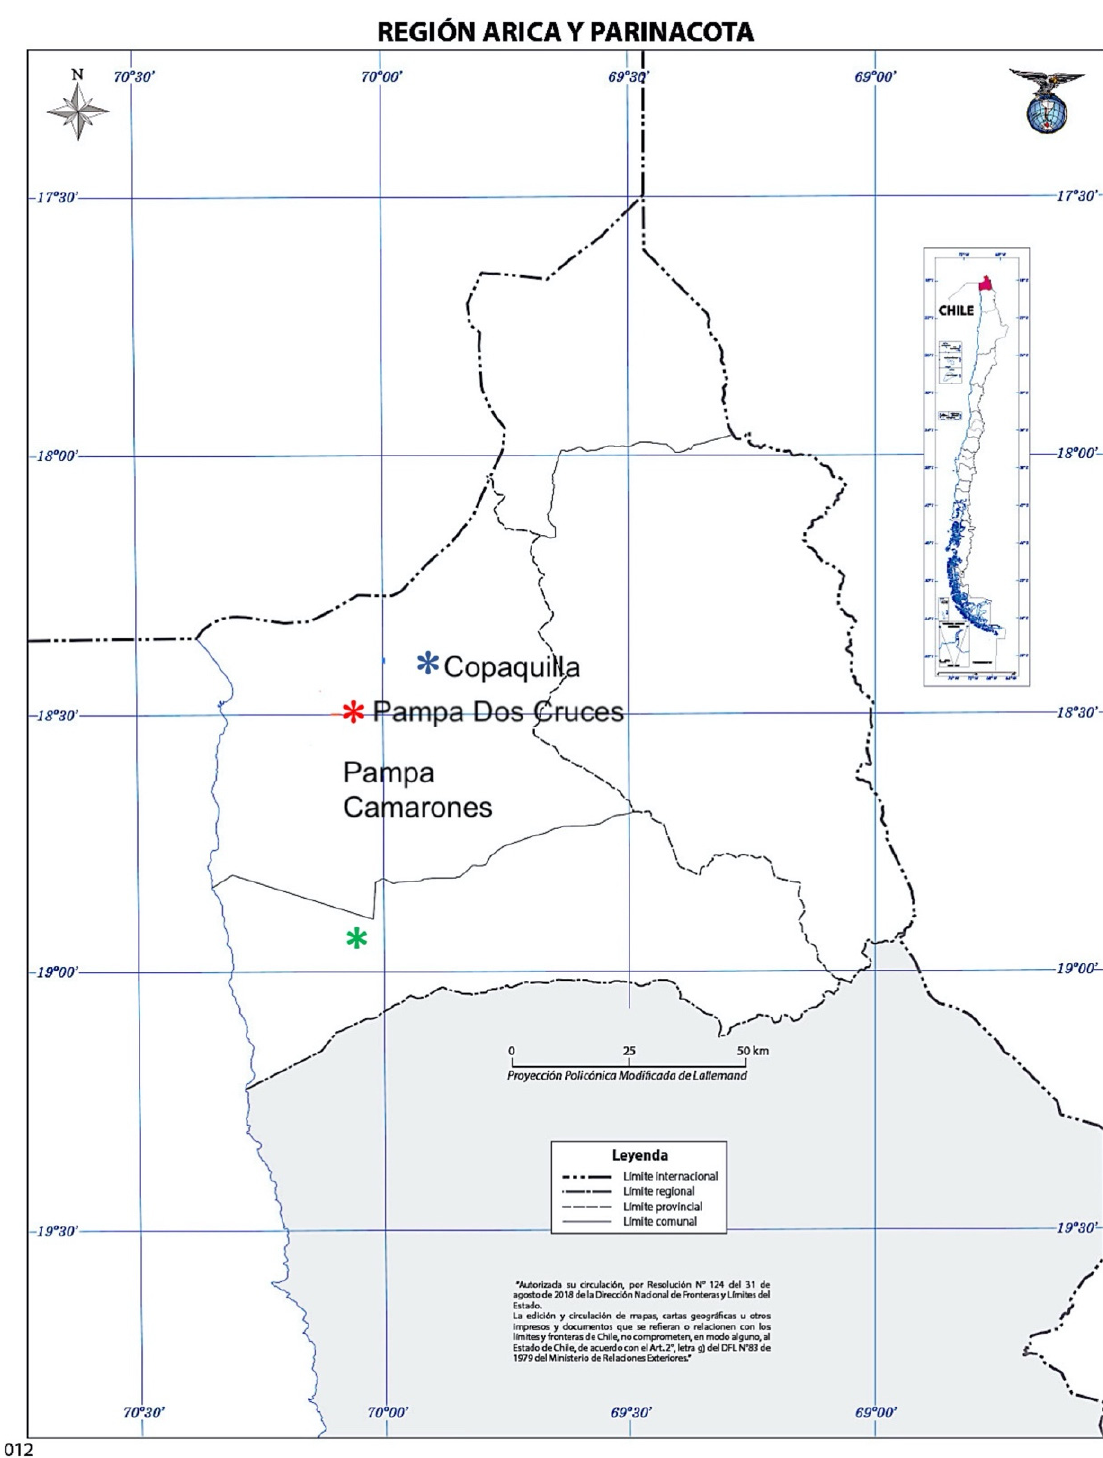
Figure 5. Sampling sites of the 3 species of Tillandsia in the region of Arica and Parinacota. 1. * Tillandsia landbeckii , Pampa Camarones, 1010 m; 2. * T. virescens , Pukara de Copaquilla, 3050 m. (Source: Google Earth). 3.